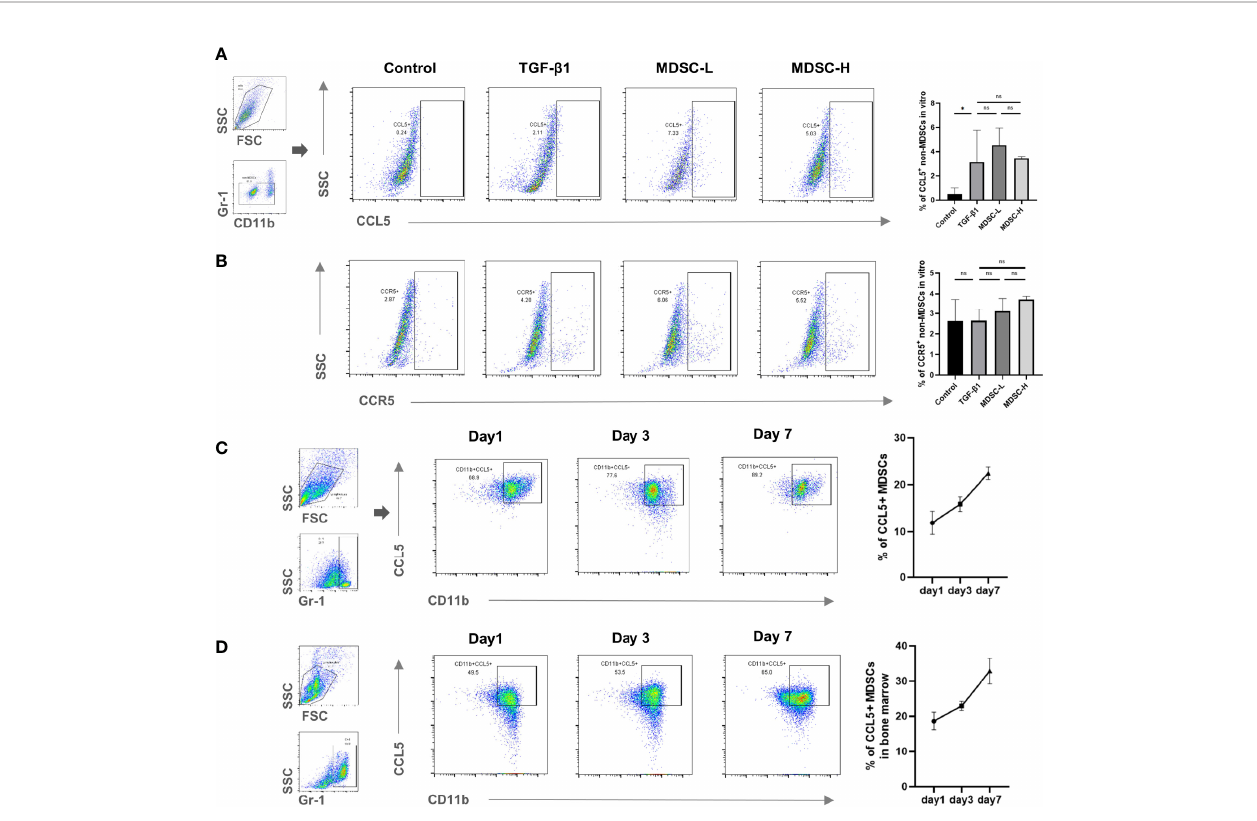
FIGURE 6 | CCL5 expression in in vitro- and in vivo -induced MDSCs. Flow cytometry detected the percentage of (A) CCL5 + non-MDSCs in in vitro experiment, (B) CCR5 + non-MDSCs in in vitro experiment, (C) CCL5 + MDSCs in in vitro -induced cells, and (D) CCL5 + MDSCs in bone marrow of mice pretreated with GM-CSF. Data are expressed as the mean ± SD (n = 6). * p < 0.05. ns^P >